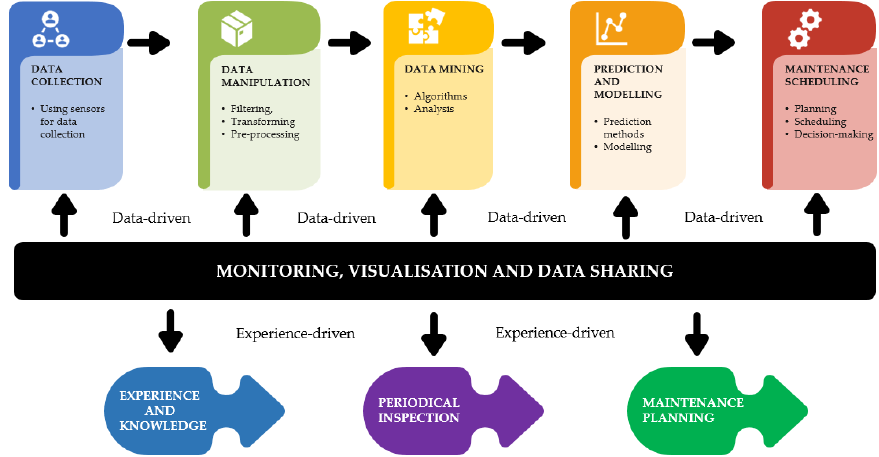
Figure 2. Experience- and data-driven predictive maintenance [38].